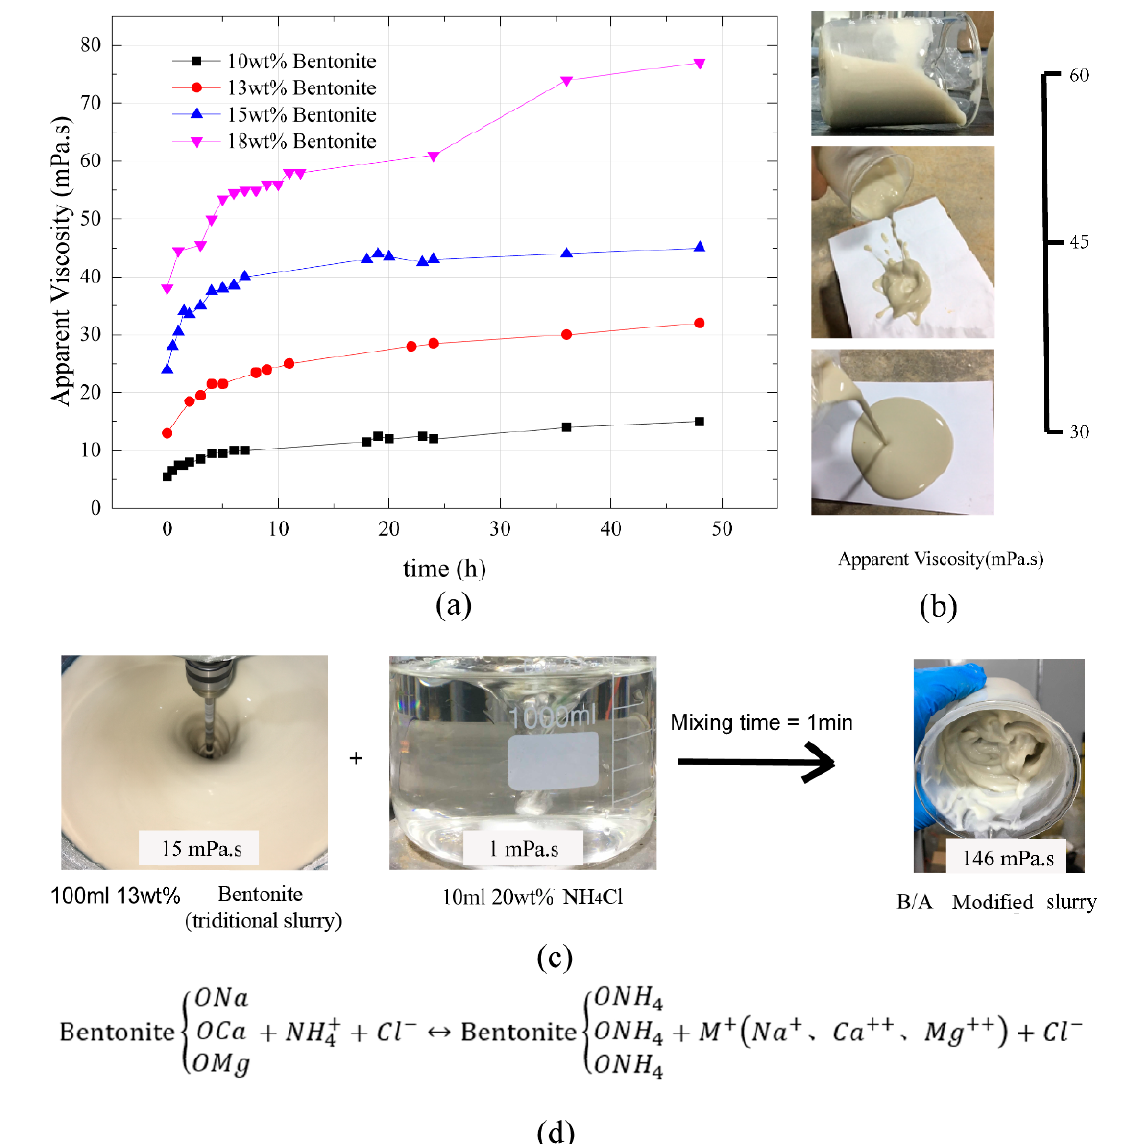
Figure 3. ( a ) The apparent viscosity of different concentrations of bentonite slurry changes with time, ( b ) Display of various apparent viscosity, ( c ) B/A modified slurry reaction process and apparent viscosity change, and ( d ) Ion exchange of ammonium in bentonite slurry.